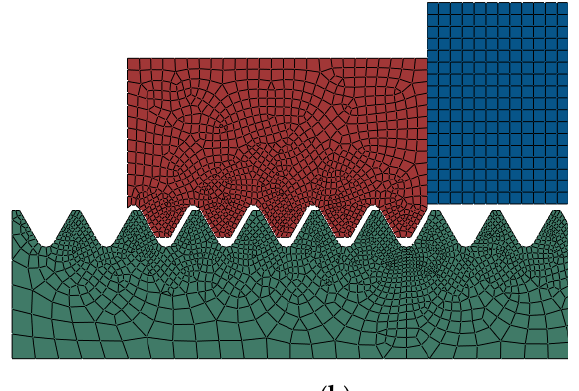
Figure 2. Detail of finite element mesh for ( a ) the stud without nut interface, and ( b ) interface stud/nut/sleeve.